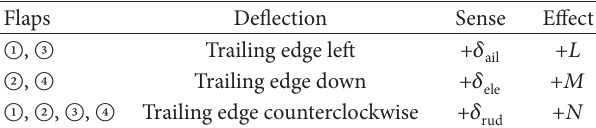
Table 1: Control surface sign